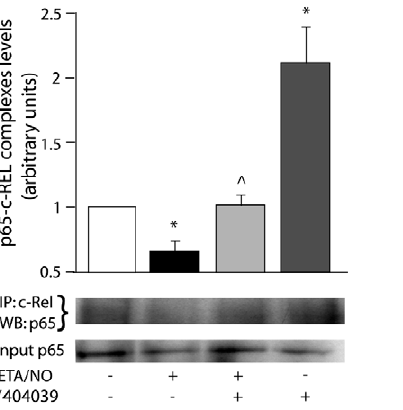
Figure 4. mGluR3 activation avoids inhibition of p65-c-Rel dimerization provoked by DETA/NO. p65-c-Rel interaction was analyzed by co-immunoprecipitation (IP) followed by western-blot (WB) of nuclear extracts from astrocytes treated with 1 mM DETA/ NO 6 100 m M LY404039 for 30 min. Levels of anti-c-Rel-immunoprecip- itated p65 were expressed relative to control group. Bars represent the mean 6 SEM of 3 independent experiments. *p , 0.05 versus control, ‘ p , 0.05 versus DETA/NO. Input corresponds to total content of p65 in nuclear extracts.